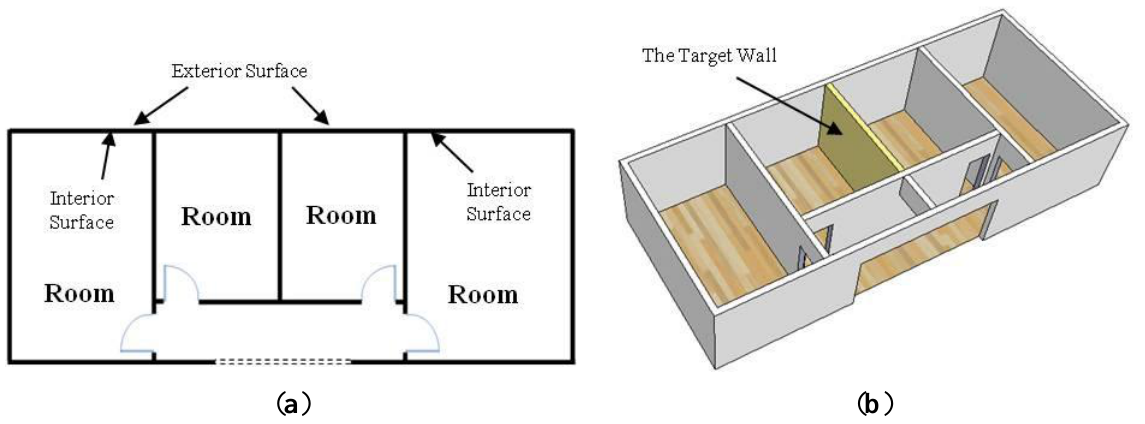
Figure 9. ( a ) Part of an architecture plan of a building. ( b ) Perspective view of the architecture